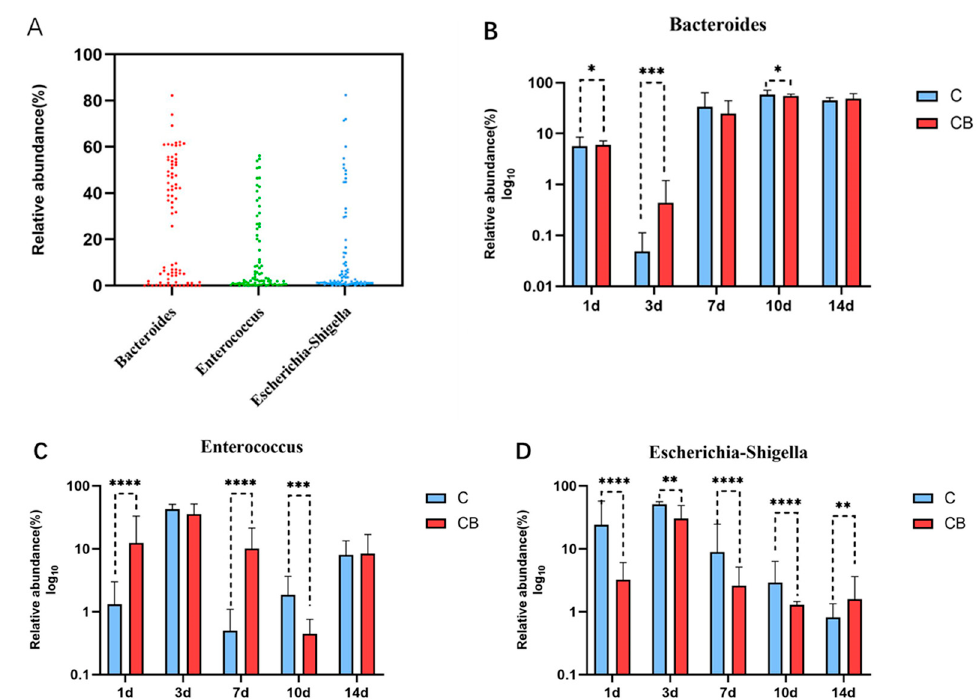
Figure 7. Core microbial taxa in the cecum of Muscovy duck. ( A ) Core microbial genera in the cecum of the Muscovy ducks. ( n = 80). ( B – D ) Relative abundance of each core genus in the C and CB groups at each sampling time point. Data were expressed as the mean ± SD ( n = 8) and analyzed by the unpaired two-tailed Student’s t -test. * p < 0.05, ** p < 0.01, *** p < 0.001, **** p < 0.0001. C, control group; CB, C. butyricum group. 1d, 3d, 7d, 10d, and 14d represent 1st day, 3rd day, 7th day, 10th day and 14th day of the present experiment,